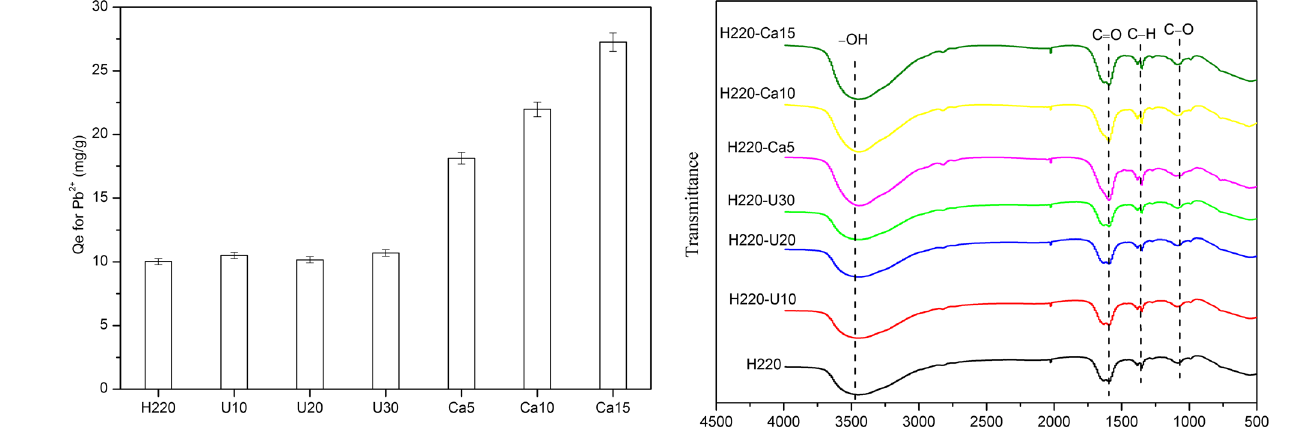
Figure 4: Adsorption capacity of di ff erent hydrochar for Pb 2 + .